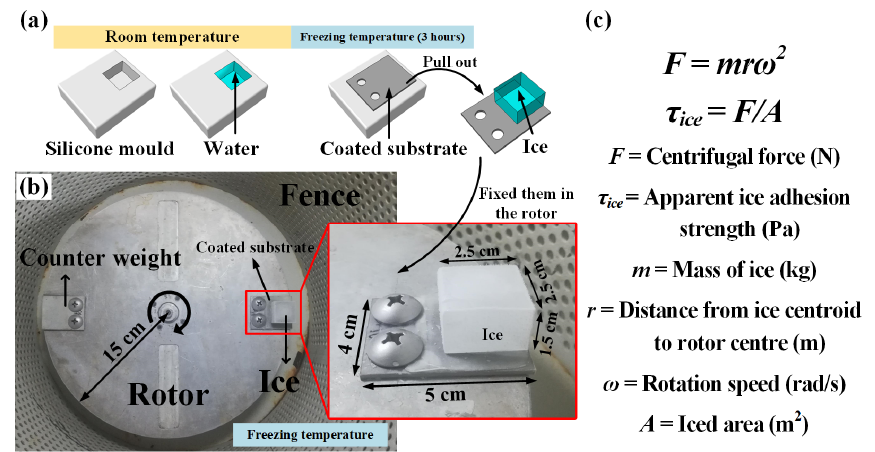
Figure 3. Schematic description of ice formation and centrifuge ice adhesion strength test. ( a ) Silicone mould was filled with deionized water. Substrate was placed upside down on the silicone mould and fully contacted with water. Temperature was set to desired temperature. After freezing, the substrate with ice was pulled out; ( b ) Substrate with ice was bolted to the discal rotor of centrifuge setup; ( c ) Formula for calculating the ice adhesion strength ( τ ice ).